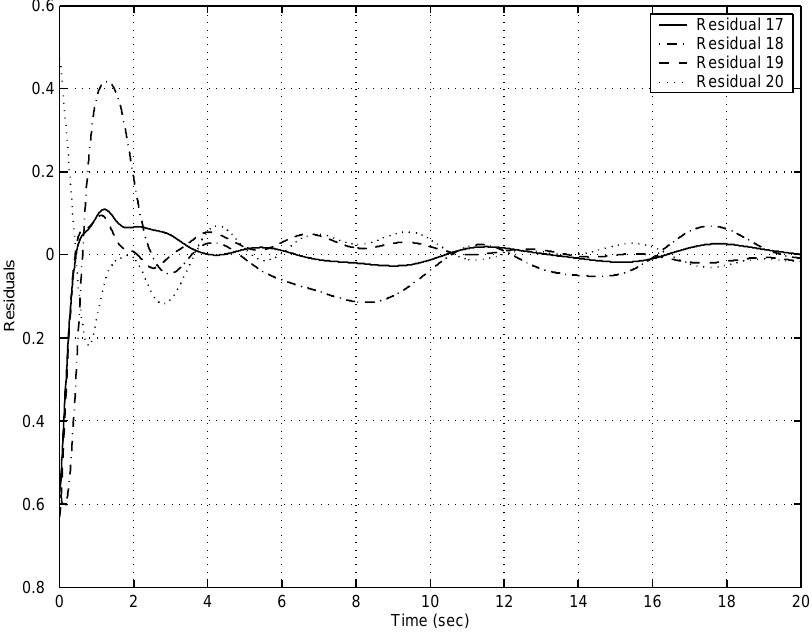
Fig. 19. Residuals 17–20 for 12 mode simulation with δ 1 = 0 . 01 .